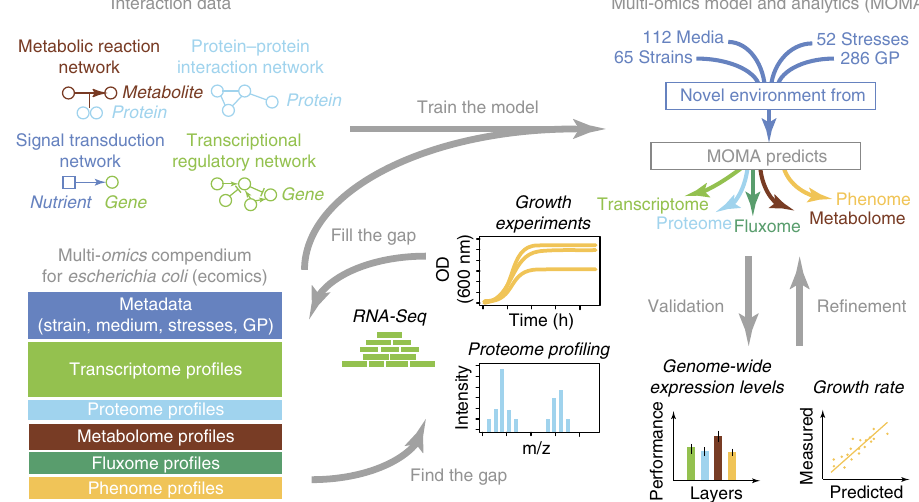
Figure 3 | Overview of the multi-omics framework. A multi-layered predictive model constructed from interaction data (metabolic reaction network, protein-protein interaction network, signal transduction network, transcriptional regulatory network) and trained on the multi-omics compendium. The model is composed of the transcriptome, proteome, metabolome, fluxome and phenome layers. GP: genetic perturbations.